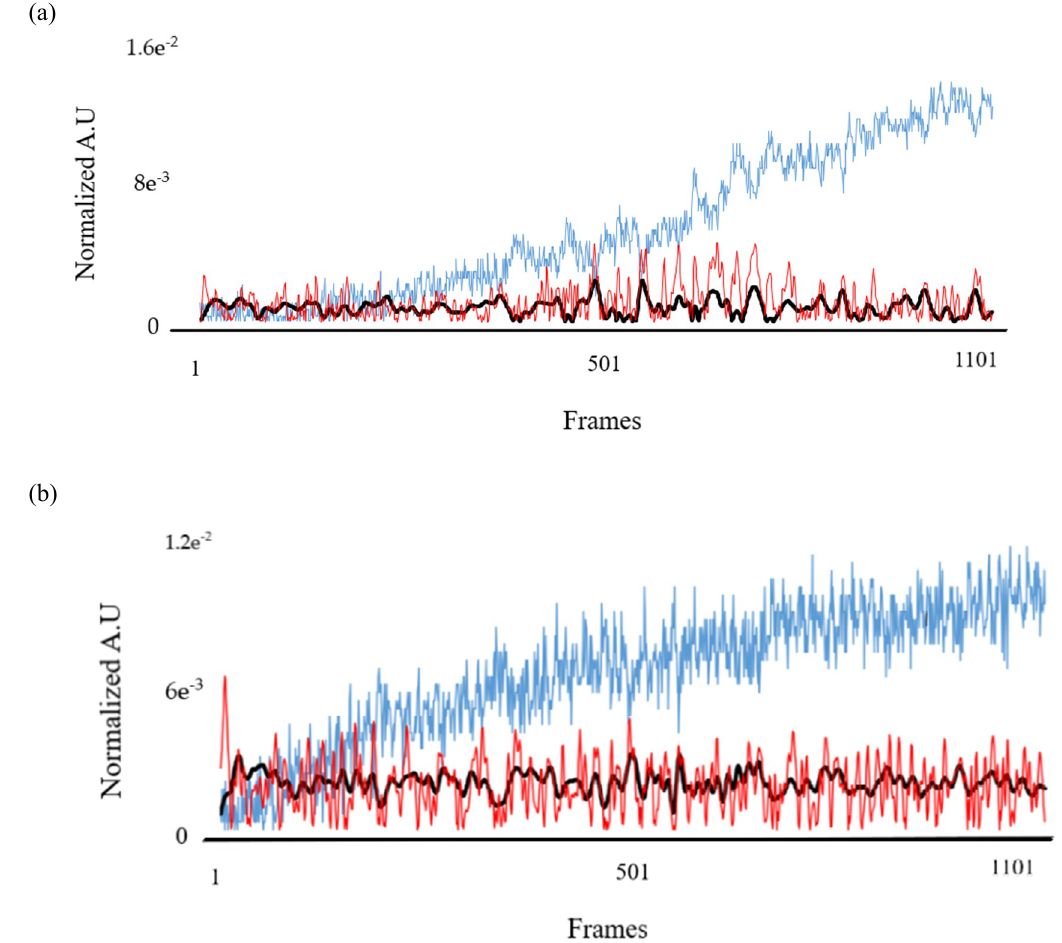
Figure 3. Representation of the average of the optical channels (2048) over time. The blue plot shows raw DOT data, the red plot shows DOT data filtered with a band pass filter, and the black plot shows DOT data after applying the Bayesian filter algorithm for 760 nm ( a ) and 830 nm ( b ). Abscissas axes correspond to normalized arbitrary units and the ordinate axis represents the experimental time in frames.